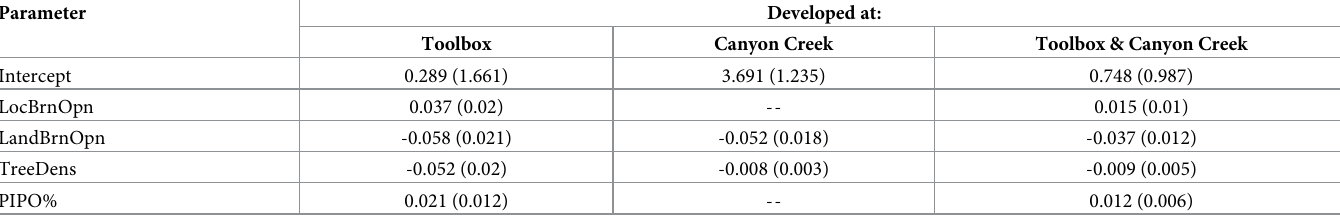
Table 6. Parameter estimates (and standard errors) for top AIC c -ranked weighted logistic regression habitat suitability index (HSI) models for nesting white- headed woodpeckers in burned forest. Models were developed with data from Toolbox, Canyon Creek, or both locations combined. Estimates and standard errors describe logit-linear relationships with HSI. Complete covariate names and descriptions are in Table